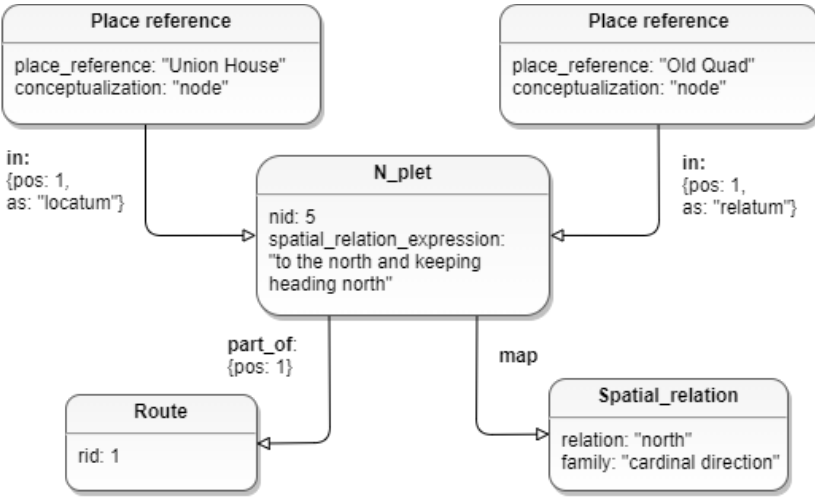
Figure A3. Creation of place reference, spatial relation, and route